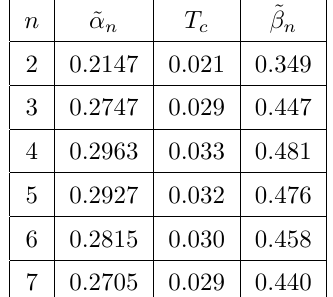
~ (cid:11) n values for the best (cid:12)t curves (3.9), upper bounds for ~ T c and ~ (cid:12) n values for the inequality (3.11).